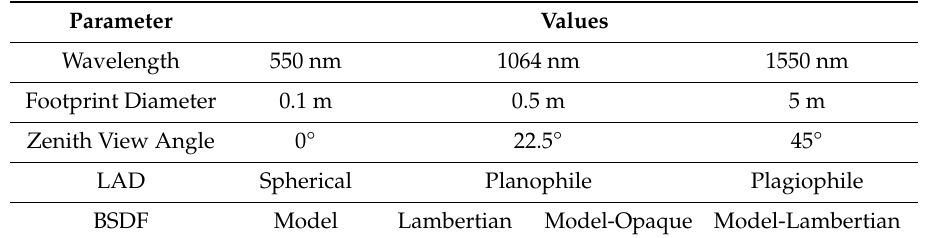
Table 3. List of parameters and associated values investigated for vegetation layer sensitivity study.